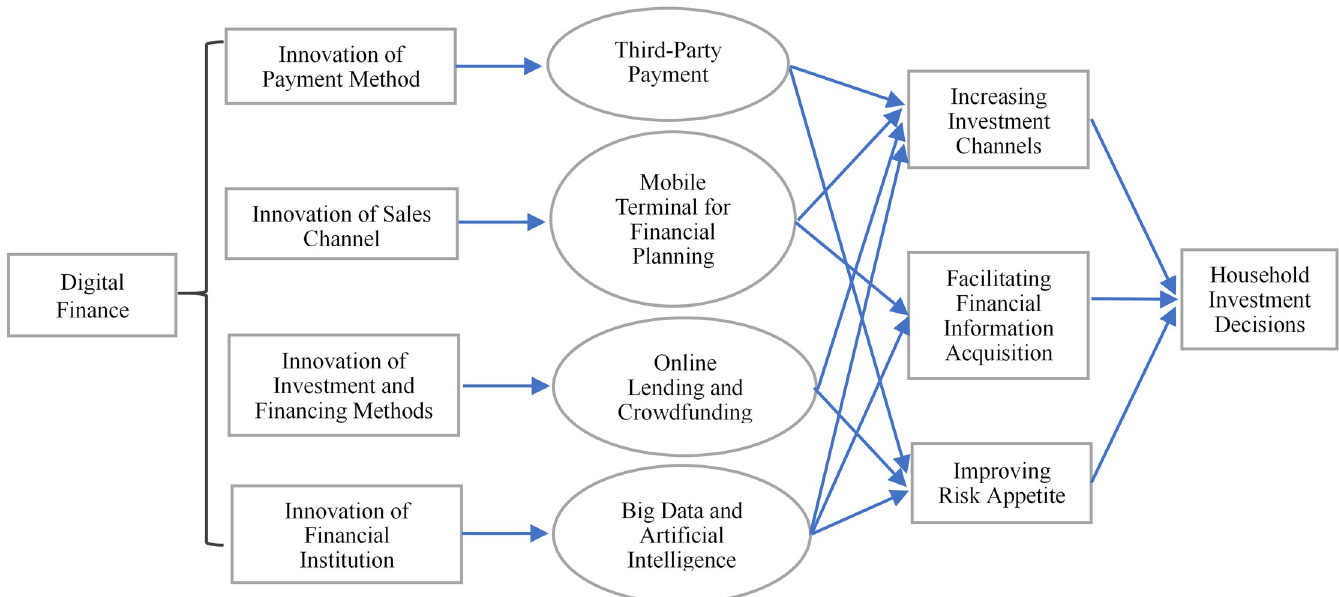
Fig 1. The path analysis of digital finance affecting household risky financial market